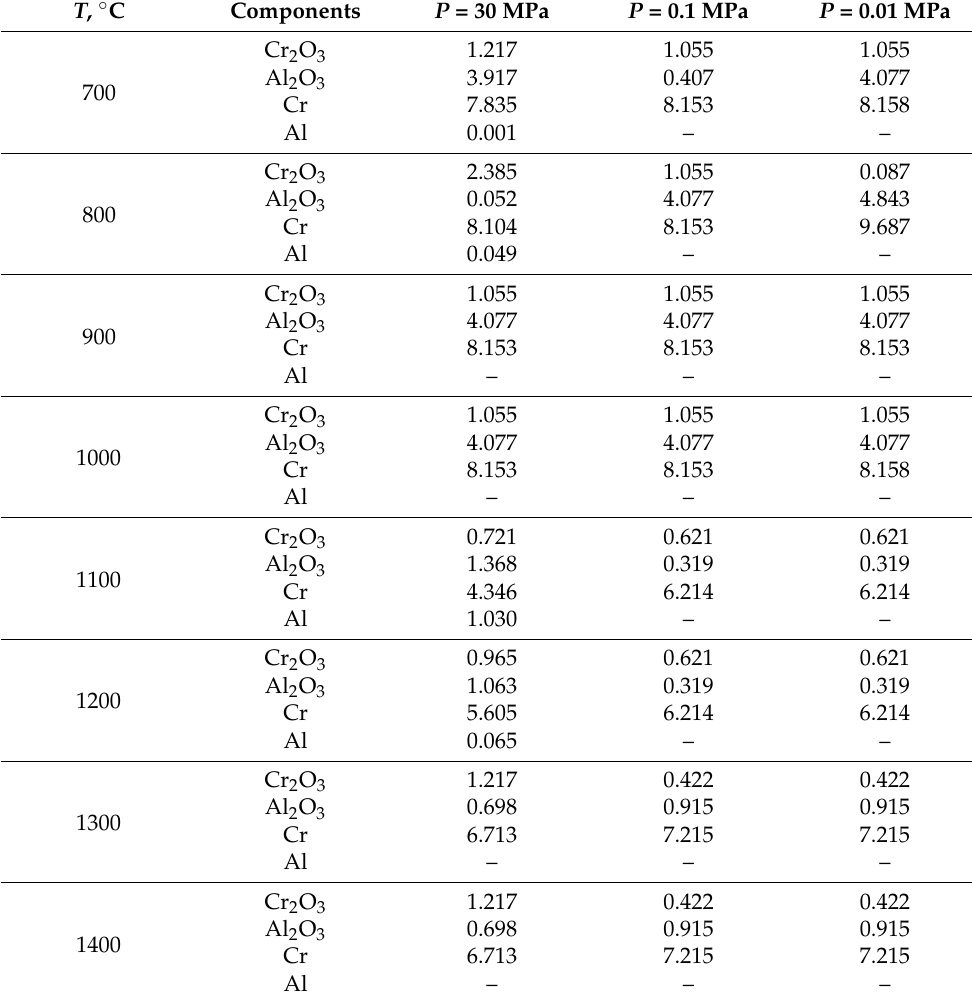
Table 1. Calculated equilibrium concentration C e in mol/L of components in the cermet obtained by hot pressing of powders Cr 2 O 3 + 13 wt.% Al under different pressure P and temperature T conditions. T , ◦ C Components P = 30 MPa P = 0.1